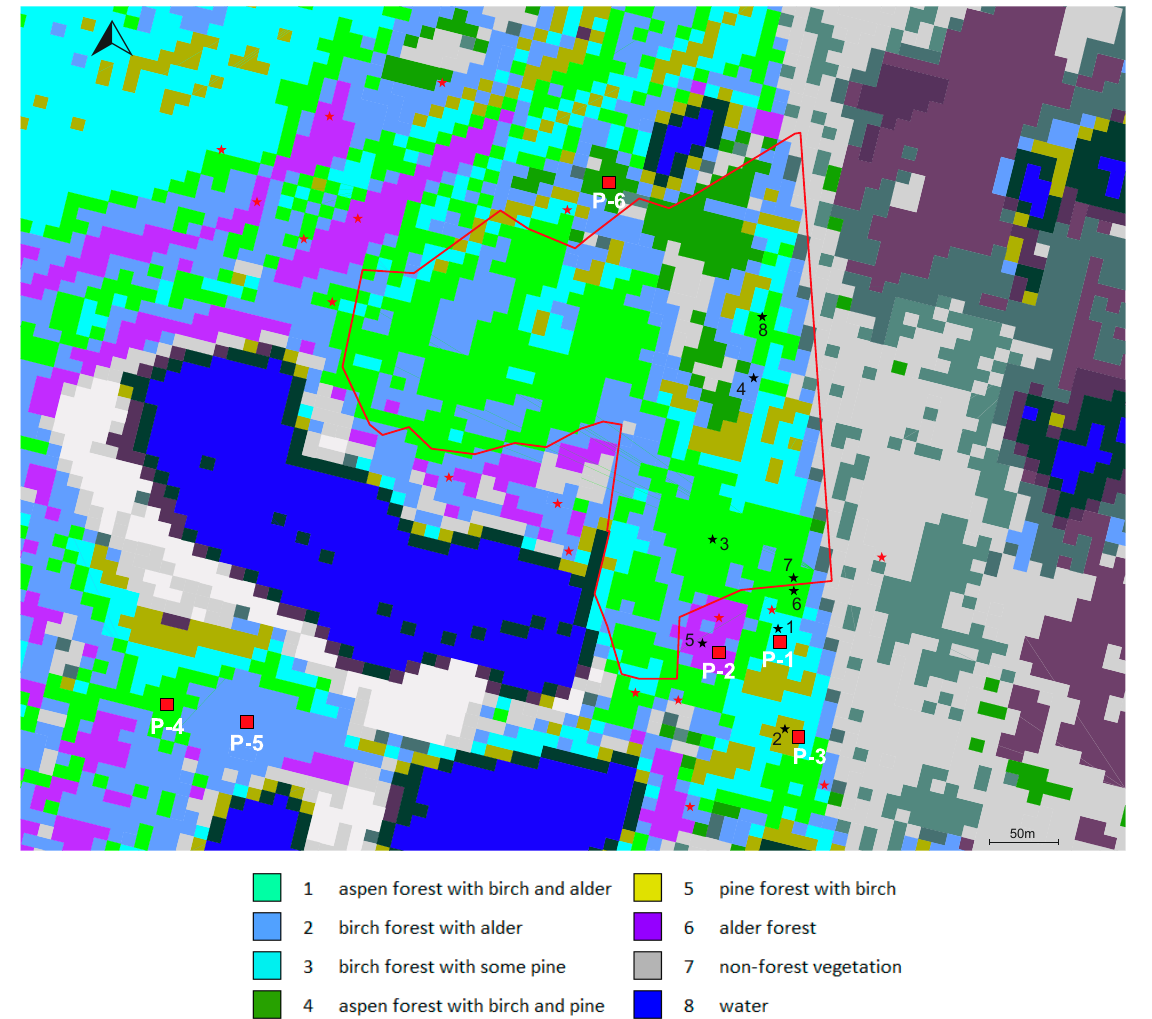
Figure 4. Results of automatic classification of the pre-fire Spot 5 image from 3 June 2007 and location of vegetation relevés (red asterisks), forest inventory plots (P-1 to P-6), and peat inventory plots (black asterisks, 1–8). The solid red line shows the boundaries of the area burned in 2010.